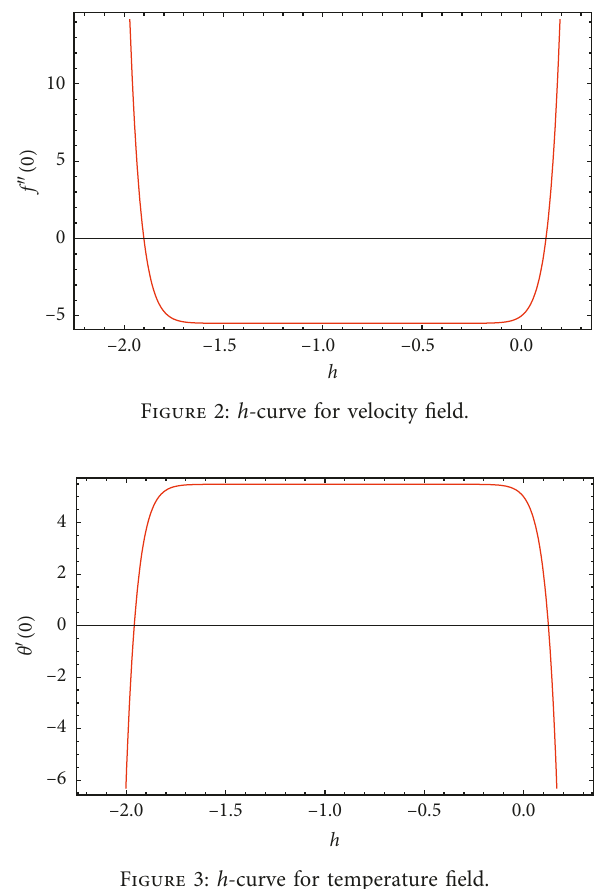
Figure 3: h -curve for temperature